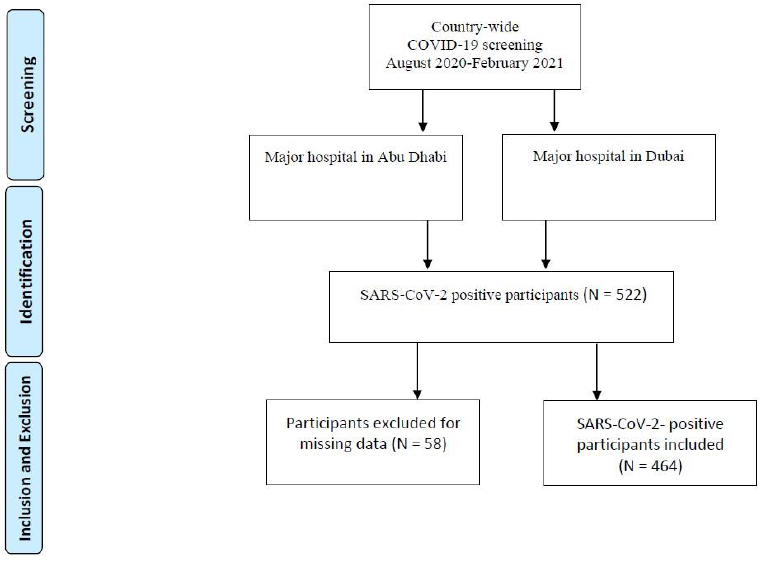
Figure 1. Flowchart diagram for selection of participants.